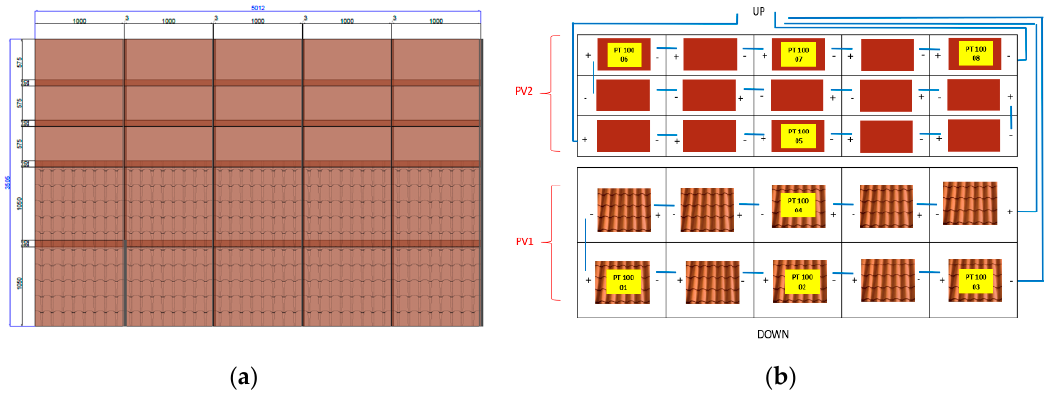
Figure 11. Testbed design: ( a ) roof layout; and ( b ) electrical configuration.